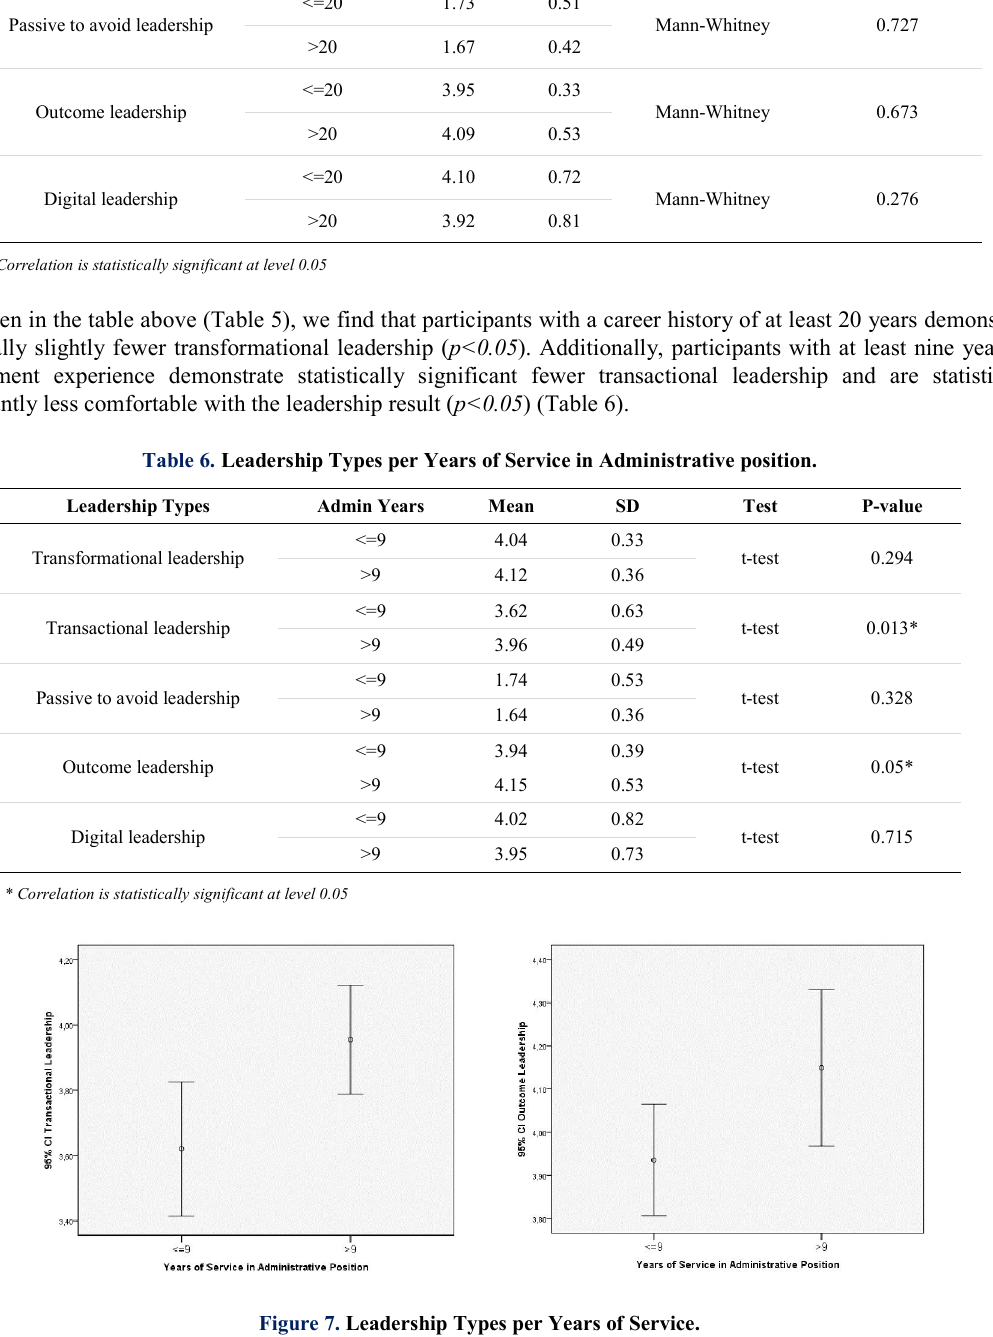
Figure 7. Leadership Types per Years of